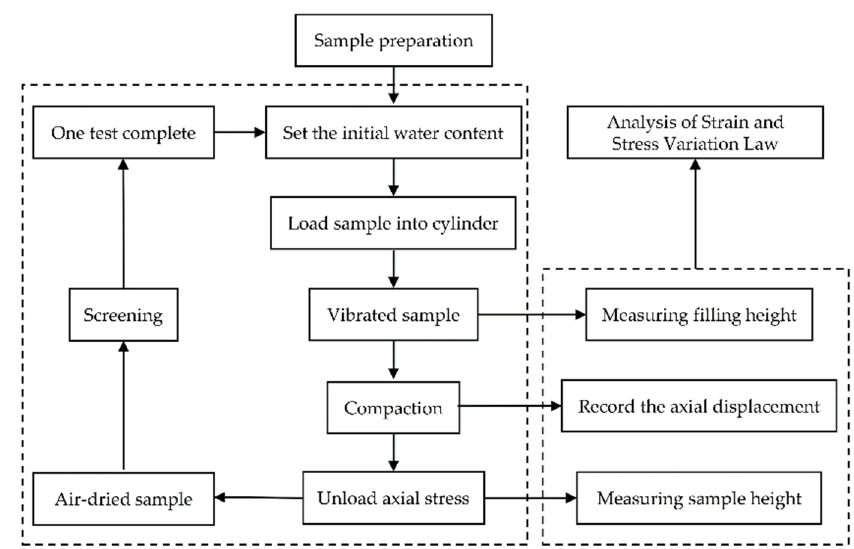
Figure 4. Workflow for confined compaction test of crushed gangue.